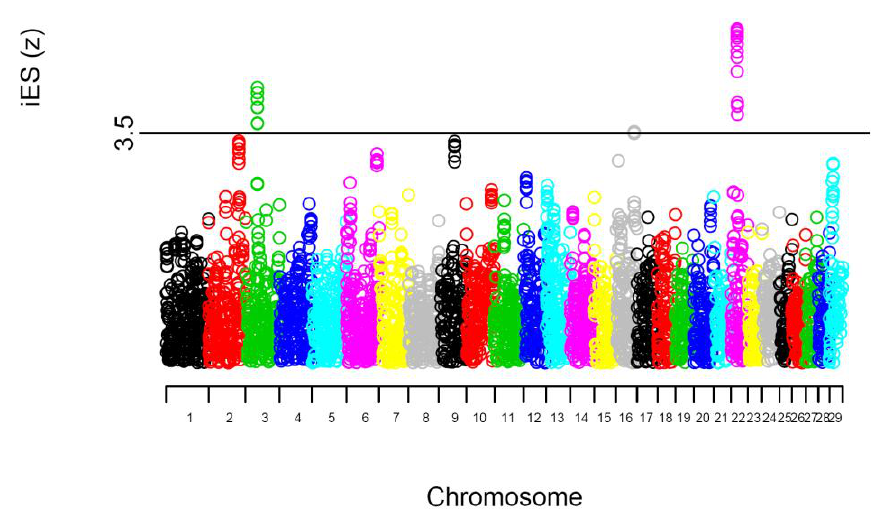
Figure 1. Genome wide extended haplotype homozygosity (EHH) profiling to detect signature of selection in